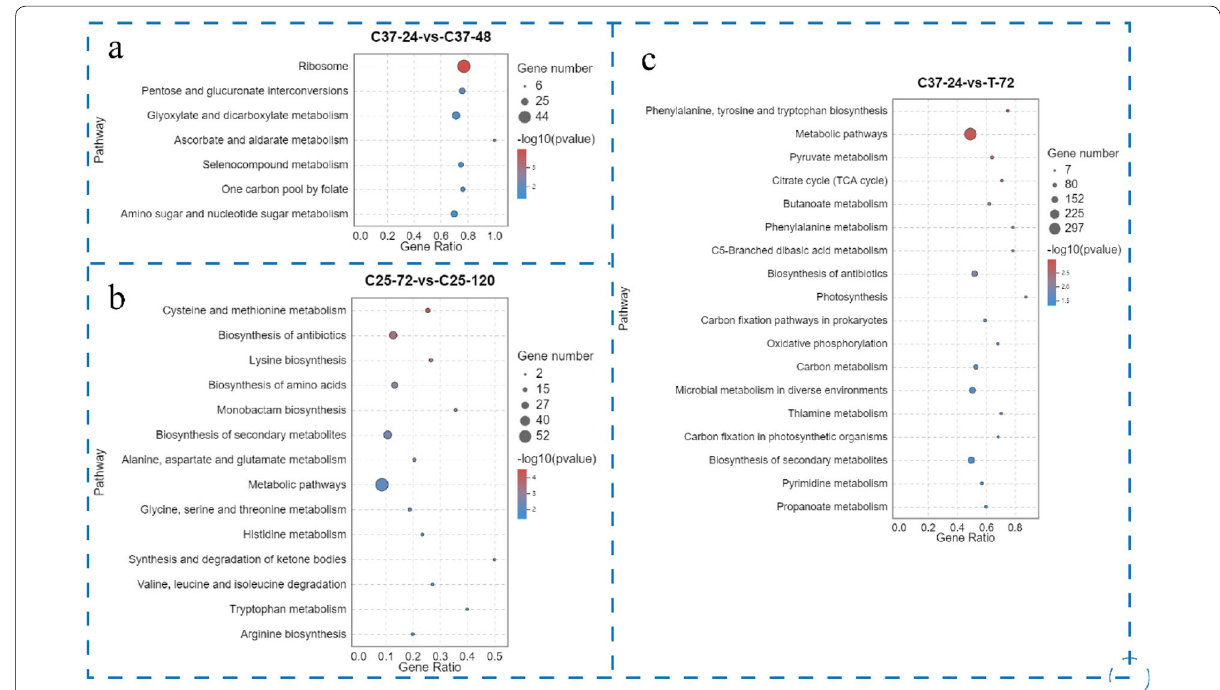
Fig. 4 KEGG pathways significantly enriched by DEGs of a C37-24-vs-C37-48, b C25-72-vs-C25-120 and c C37-24-vs-T-72 ( P <